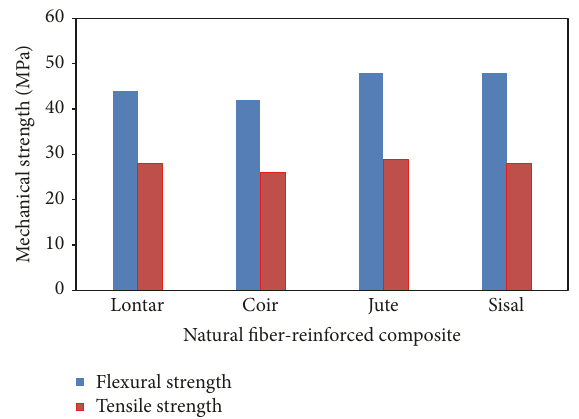
Figure 1: Mechanical strength of natural fiber-reinforced compos-